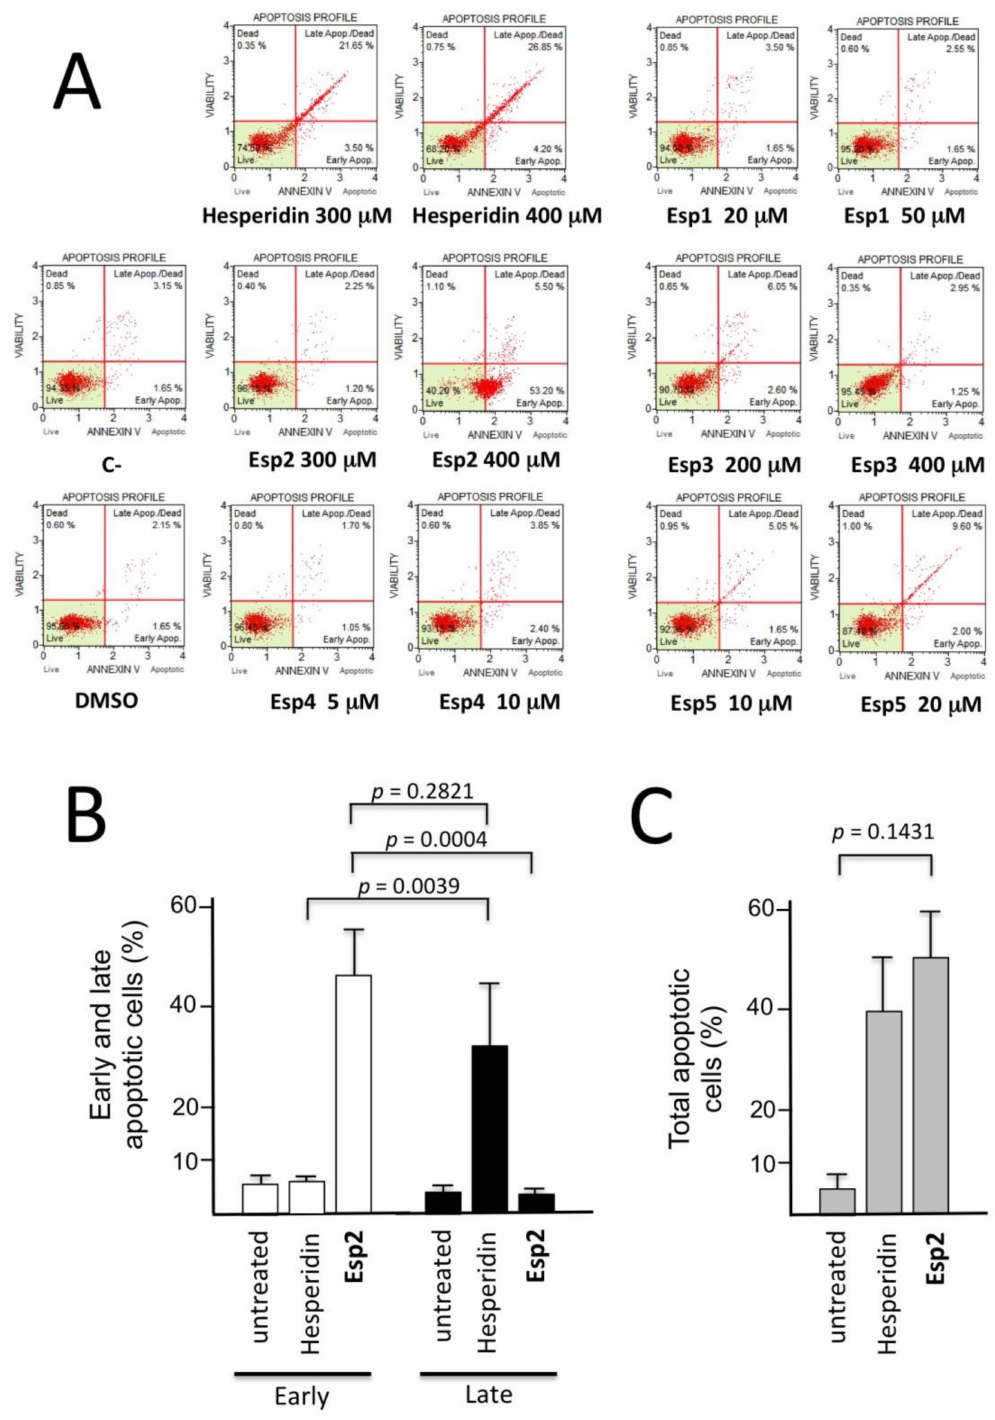
Figure 2. Annexin-V assays were performed on K562 cells treated for 72 h with the indicated concentrations of hesperidin and semi-synthetic analogues. ( A ) Representative examples showing that the best effects (total apoptosis >30%) on K562 cells treated with the hesperidin and its derivative Esp2 are here reported in comparison with untreated cells (negative control, C-). Also Esp5 demonstrated to induce late apoptosis (11.60%). ( B , C ) Summary of the results obtained from five independent experiments. K562 cells were treated for 72 h with 400 µ M hesperidin and Esp2 , as indicated and the apoptosis assay was performed as described in panel A. The results represent the average ± S.D., of five independent